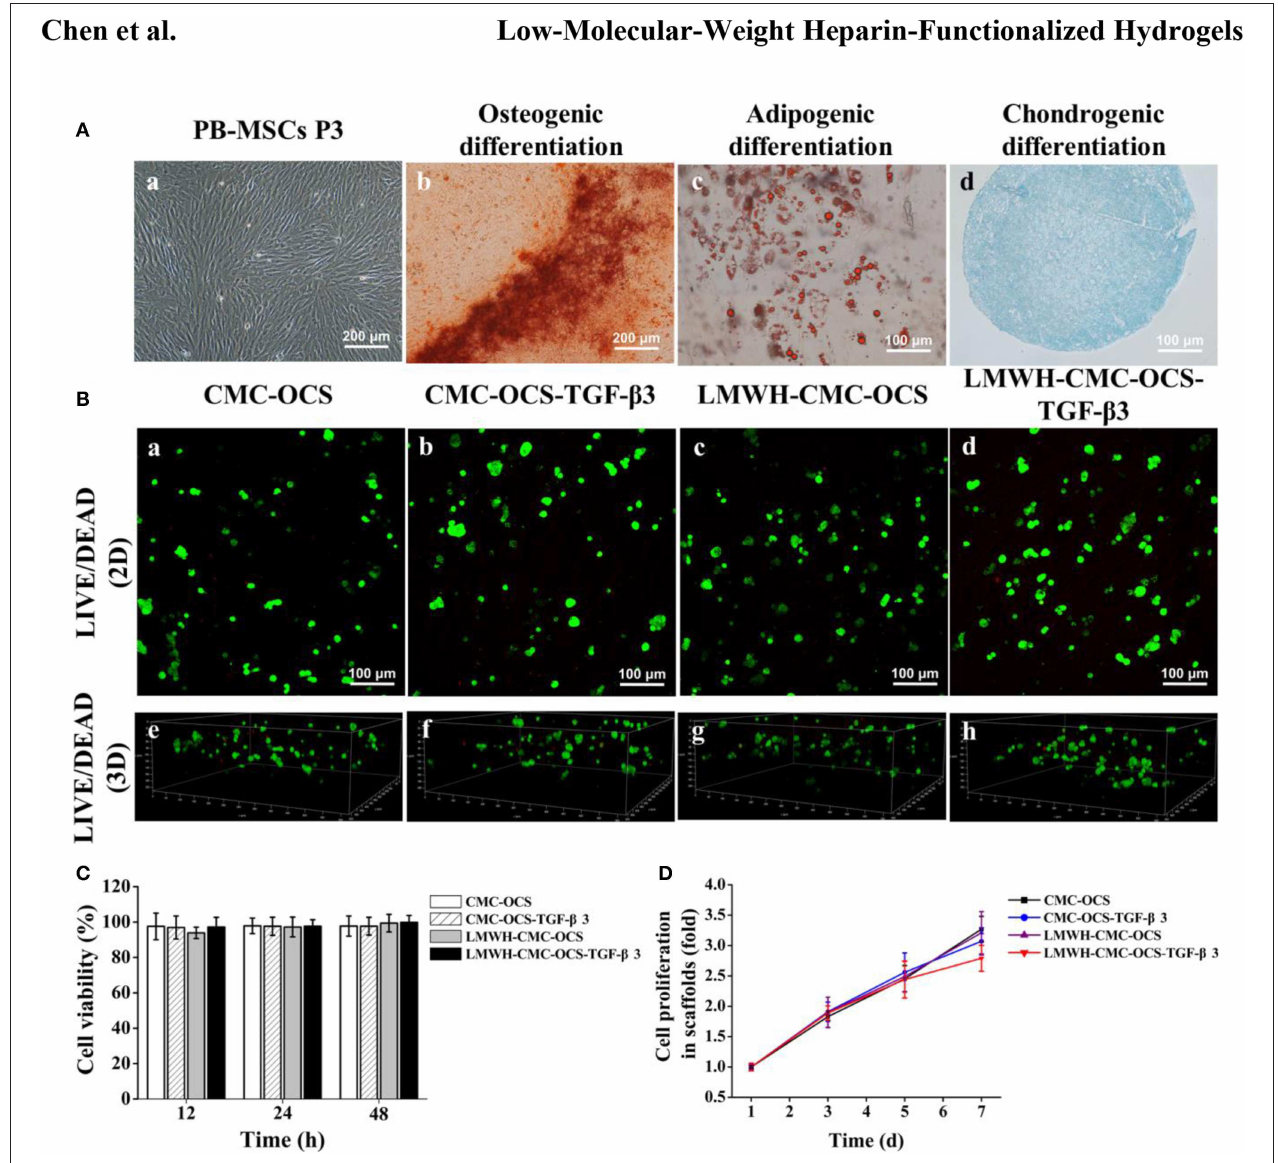
FIGURE 6 | (A) The morphological characteristics and multilineage differentiation potential of PB-MSCs. a. PB-MSCs showed a typical spindle shape at passage 3 in vitro ( × 100). b. Osteogenic differentiation was assessed by Alizarin red staining. c. Adipogenic differentiation was detected by Oil Red O staining. d. Chondrogenic differentiation was confirmed by Alcian Blue staining. (B) LIVE/DEAD staining of PB-MSCs on various hydrogels. a–d. Cell viability of four groups in hydrogels was demonstrated by using Live/Dead staining after 7 days of culture in vitro . Green represented live cells and red represented dead cells. e–h. 3D renderings of PB-MSCs to show distribution of live and dead cells in hydrogels after 7 days of culture. (C) Detection of cytotoxicity of hydrogels using CCK-8 assay ( n = 5, P > 0.05). (D) CCK-8 assay detected the cell proliferation of four groups over time, the cell proliferation curves of each groups obtained by normalizing the OD value at each point against the average value of the first